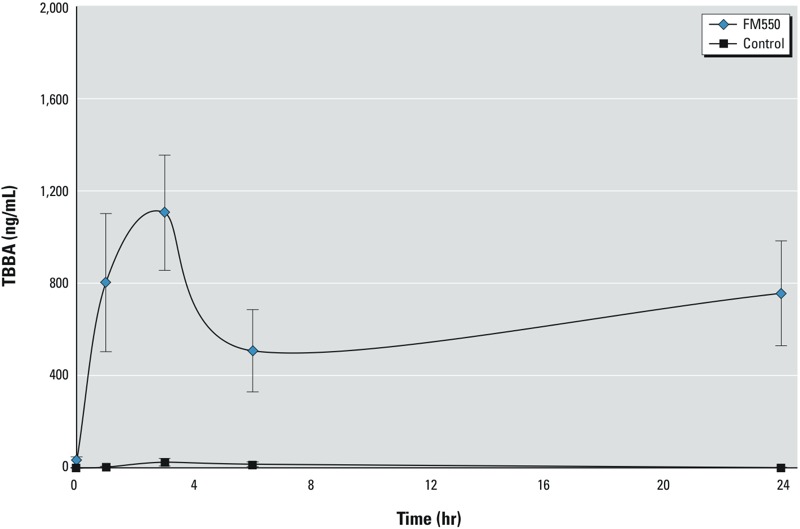
Mean (± SE) TBBA in urine samples from adult female rats administered either 1 mg FM550 or ethanol vehicle (control) one time via a treat pellet; n = 6/treatment group. TBBA concentrations were measured at 1, 3, 6, and 24 hr after treatment (time zero).